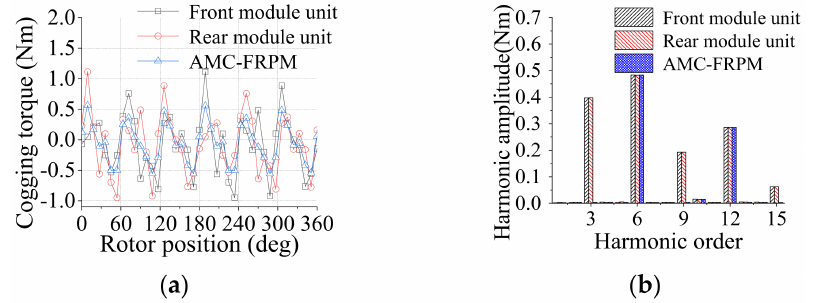
Figure 9. Cogging torques of the AMC-FRPM machine and a single module. ( a ) Cogging torque waveforms. ( b ) Harmonic distributions.